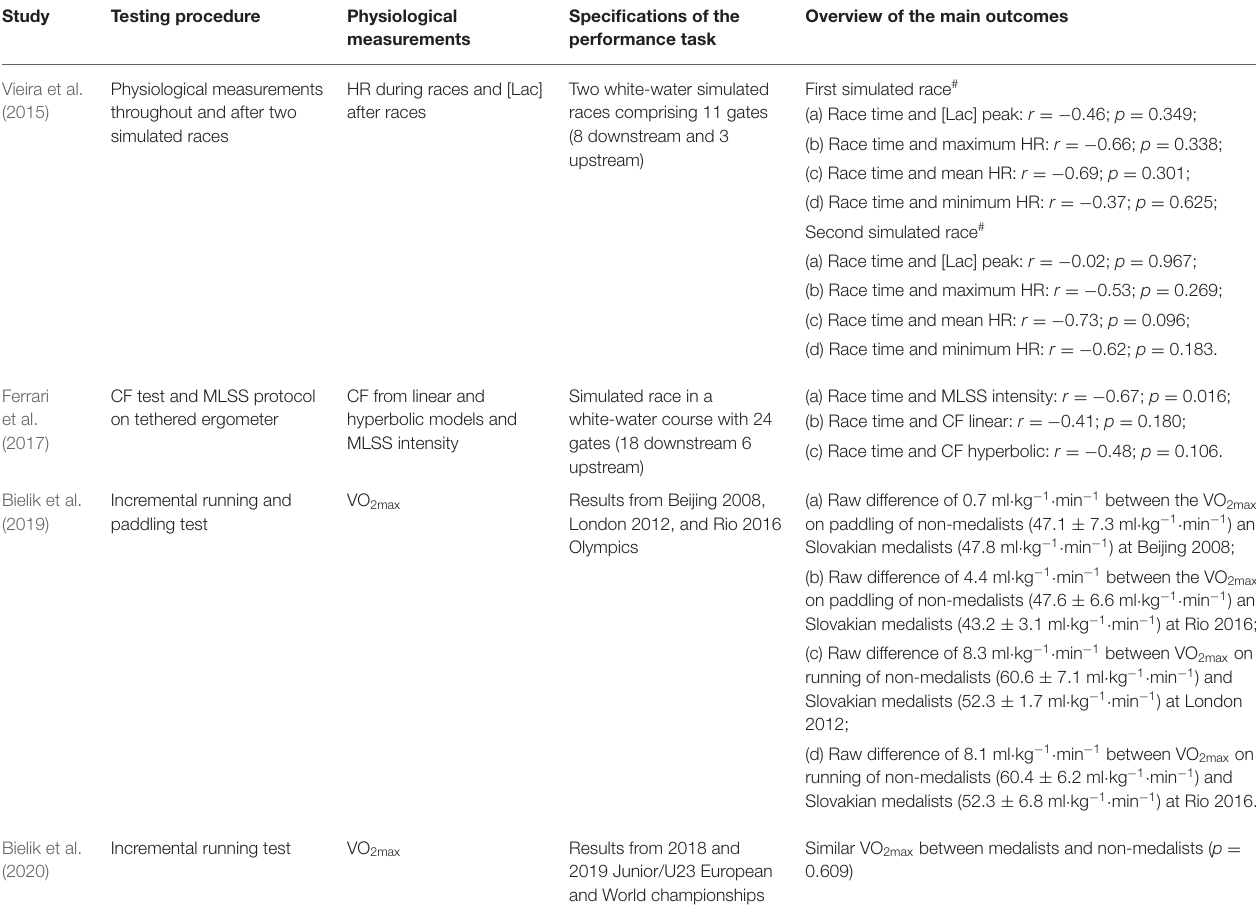
TABLE 3 | Methodological aspects and main results from studies that associated the slalom performance with physiological parameters or compared physiological data between athletes with distinct canoe slalom performances.